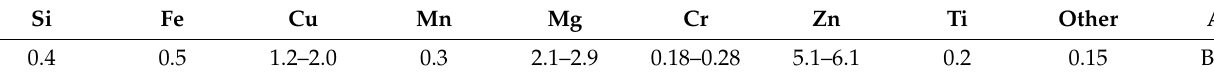
Table 3. Chemical composition of Al-7075 (wt.%).